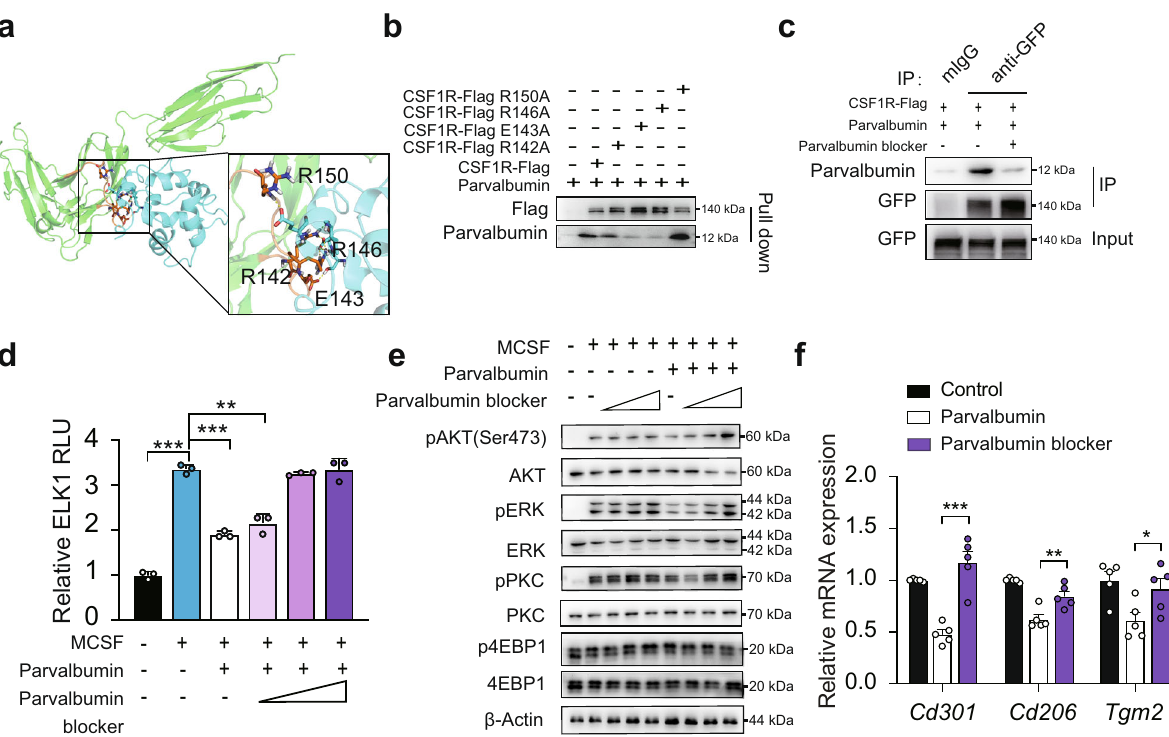
Fig. 4 Parvalbumin blocker which blocks Parvalbumin and CSF1R interaction, promotes M2 macrophage polarization. a Proposed docking interface between parvalbumin and CSF1R based on molecular docking. CSF1R and parvalbumin are shown in green and blue respectively. The fragment M141-Y154 of CSFR1 is highlighted in orange. The residues in hydrogen bond network are shown in sticks. b CSF1R E143A and R146A abrogated the interaction with parvalbumin. c Parvalbumin blocker (1 μ g/ml) blocked parvalbumin-CSF1R interaction. d Effect of parvalbumin blocker on ELK1 luciferase reporter activity in 293 T transfected with CSF1R (concentrations of parvalbumin blocker: 0.1 μ g/ml, 1 μ g/ml, 10 μ g/ml, n = 3 per group). Effect of M-CSF with or without parvalbumin was shown ( n = 3 per group). P value: <0.0001, <0.0001 and 0.0009. Parvalbumin blocker rescued parvalbumin suppression of M2 macrophage activation. MCSF-induced mTORC2 downstream targets and ERK activation (concentrations of parvalbumin blocker: 0.1 μ g/ml, 1 μ g/ml, 10 μ g/ml) ( e ) and M2 macrophage marker gene expression (concentrations of parvalbumin blocker: 1 μ g/ml) ( f ) ( n = 5 per group) in BMDM were shown. P value: 0.0003, 0.0100, 0.0415. Data are represented as mean ± SEM. P values were determined by unpaired two-tailed Student ’ s t test ( d and f